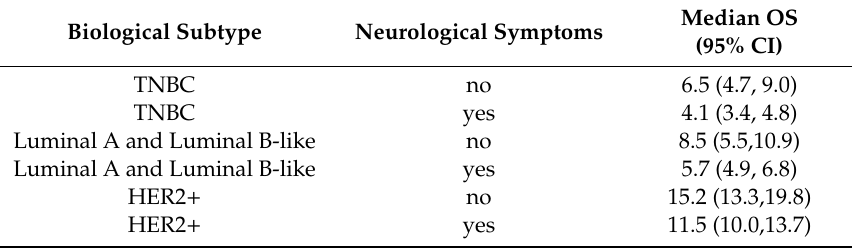
Table 4. Median OS in different groups of biological subtypes for symptomatic and asymptomatic